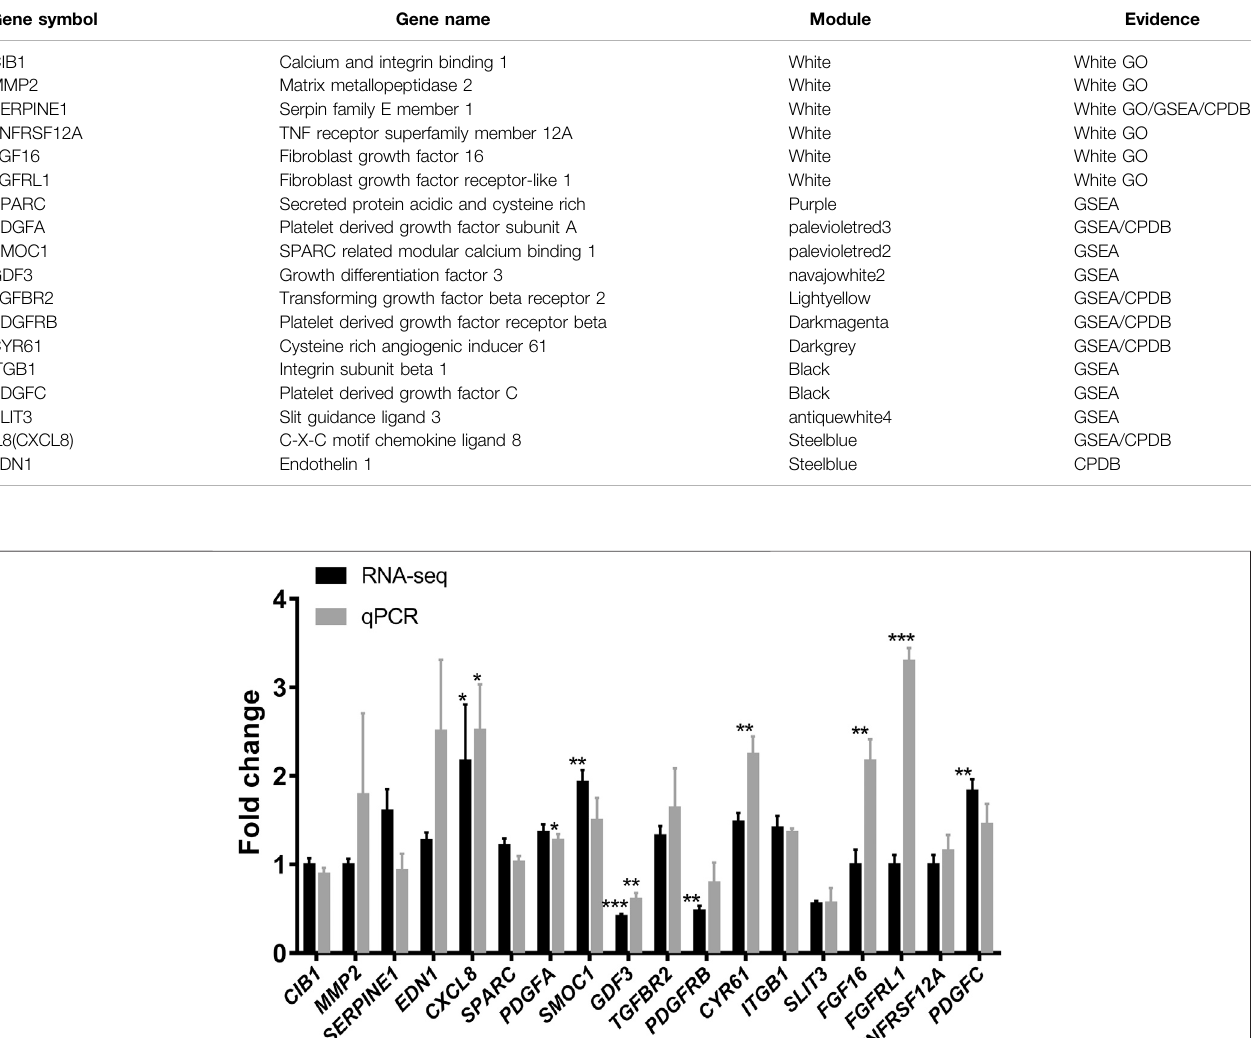
TABLE 4 | List of 18 genes selected from preceding analyses for con fi rmation by qPCR. The fi rst six genes were suggested by the WGCNA method with GO annotation (White GO module), while the remaining 12 genes were identi fi ed by DESeq2 in combination with either GSEA or CPDB pathway analysis. Five genes (CIB1, MMP2, TNFRSF12A, FGF16, FGFRL1) have been chosen by theWGCNA method only and not byDESeq2, indicatingthose genes from the most highly correlated module may still be important in angiogenesis pathways, despite not being signi fi cantly differentially expressed.